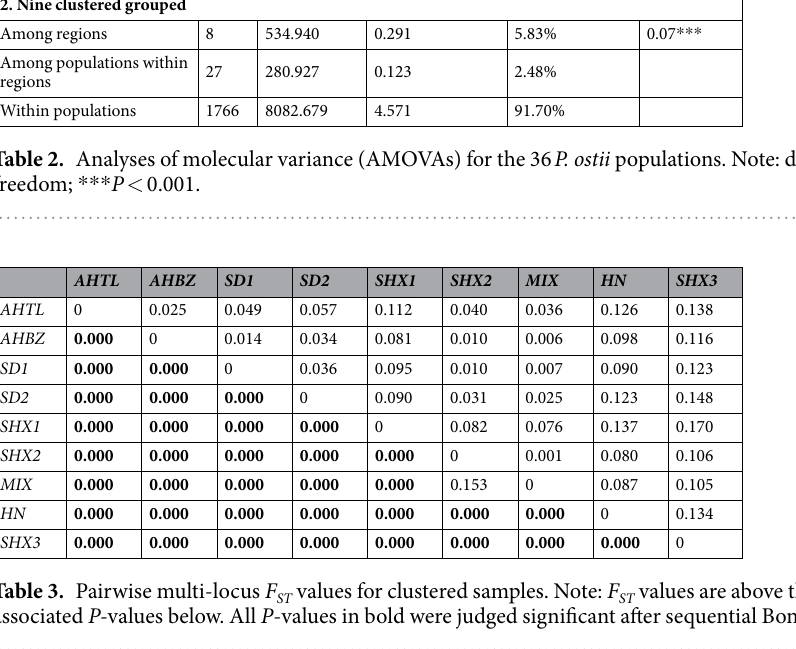
Source d.f. 1. Total